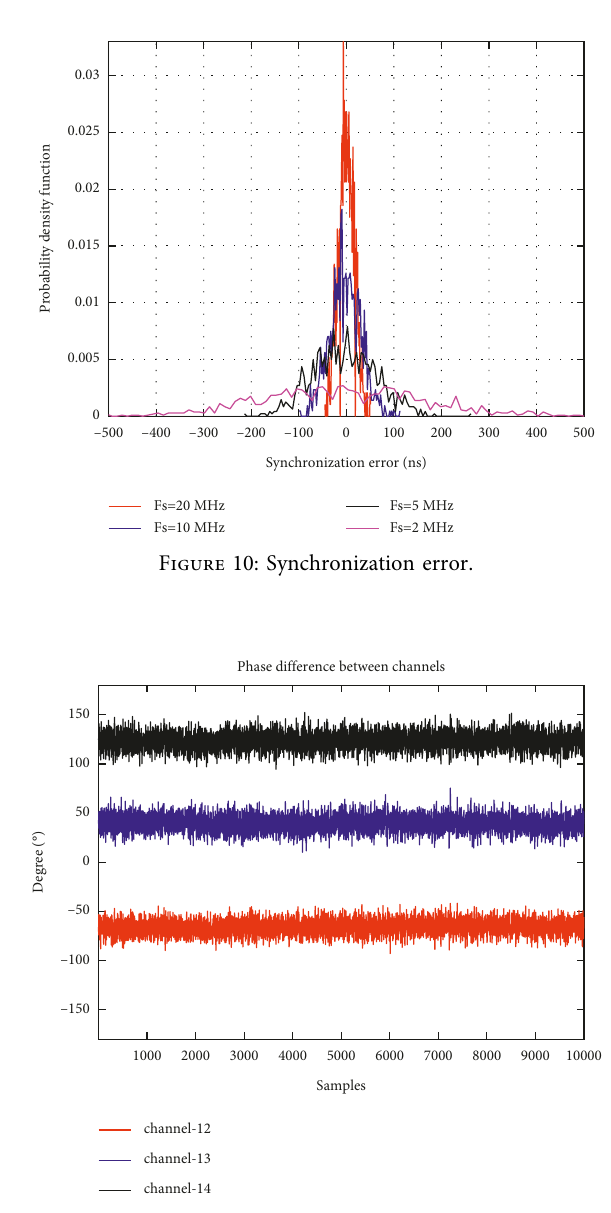
Figure 11: The phase difference between channels before